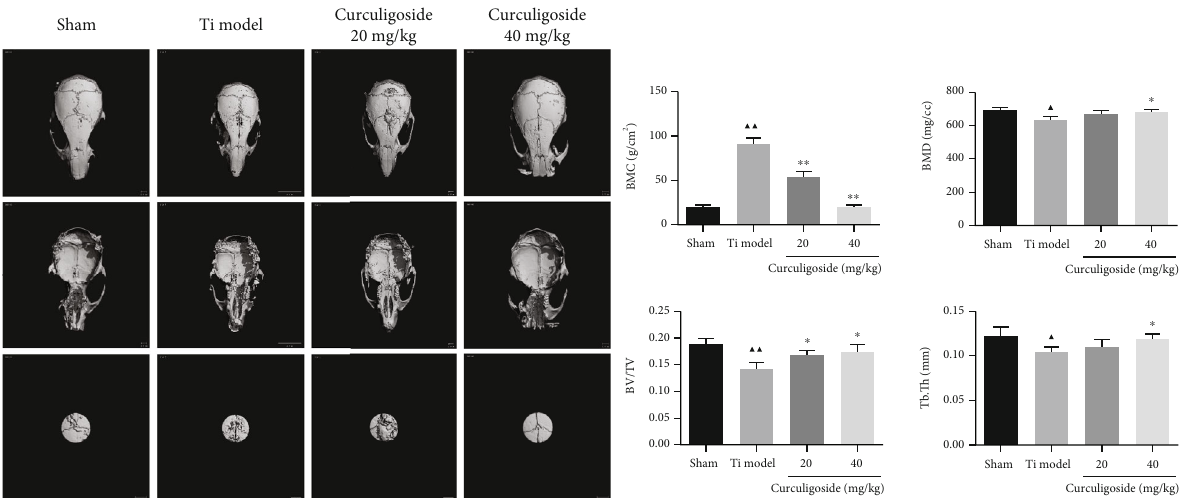
Figure 7: Curculigoside treatment attenuated Ti-induced osteolysis in a mouse calvaria model. (a) Micro-CT reconstruction images of the calvaria in each group of mice. (b) BMC, BMD, BV/TV, and Tb.Th were determined ( n = 3 ); results are represented as the mean ± SD . ▲ P < 0 : 05 , compared to the sham group; ▲▲ P < 0 : 01 , compared to the sham group; ∗ P < 0 : 05 , compared to the Ti group; ∗∗ P < 0 : 01 , compared to the Ti group. Ti: titanium particle; BMC: bone mineral content; BMD: bone mineral density; BV/TV: bone volume to tissue volume; Tb.Th: trabecular thickness.